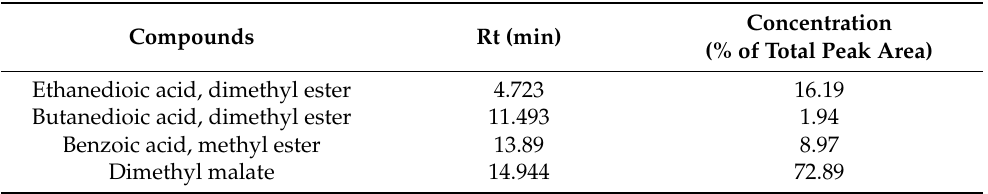
Table 3. Volatile compounds composition of Dichrostachys cinerea ethanolic (DC_EtOH_1) extract identified by